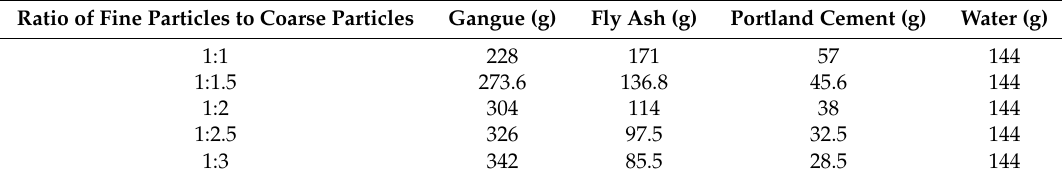
Table 7. Ratio of the slurry composition at different ratios of fine particles to coarse particles. Ratio of Fine Particles to Coarse Particles